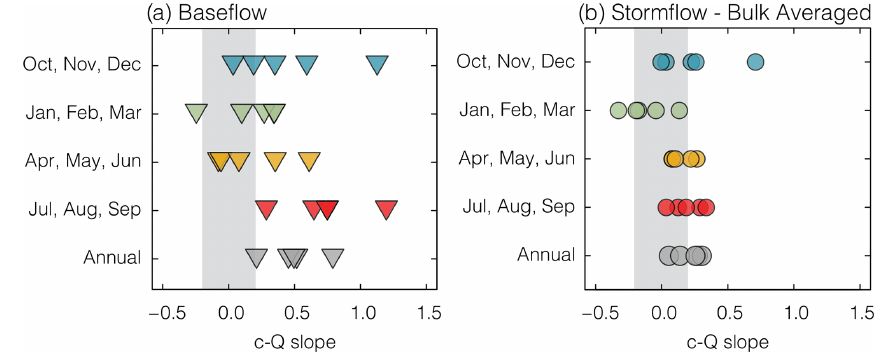
Figure 4. Concentration–discharge slopes in each watershed calculated independently for baseflow (a) and bulk stormflow (b) for each season and annually (gray). Gray boxes indicate chemostatic behavior ( | c – Q slope | ≤ 0 .